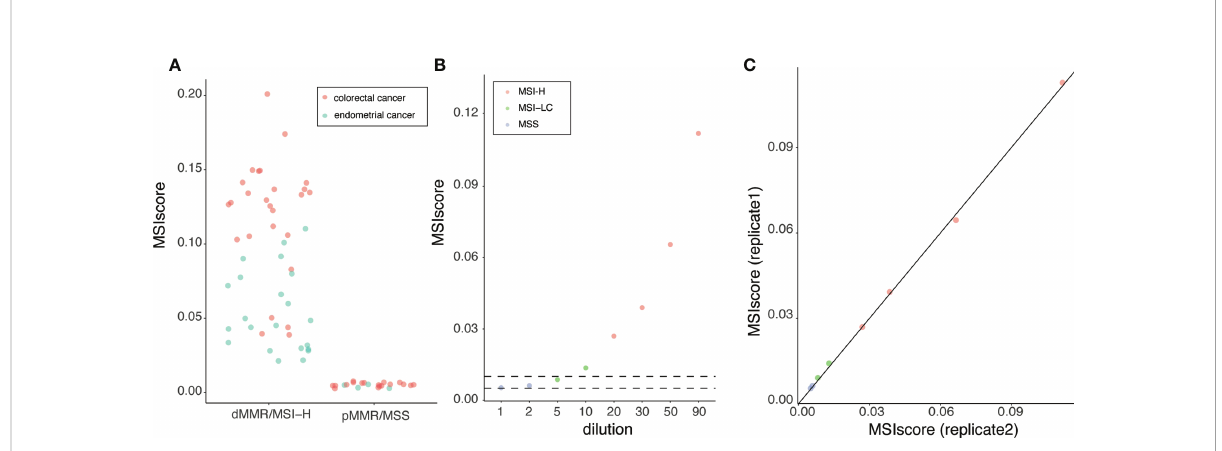
FIGURE 3 MSI detection in colorectal and endometrial FFPE clinical samples (A) MSIscore obtained for colorectal or endometrial cancer samples. Samples were grouped based on their respective MSI-PCR and IHC result. Each point corresponds to one sample colored by tissue of origin (refer to legend in fi gure) (B) MSIscore for a dilution series containing between 1 and 90% (x-axis) of DNA extracted from one MSI-H tumor DNA diluted in MSS tumor DNA in duplicates. Each point corresponds to one sample. Samples are colored according to results of MSI-PCR test (refer to legend in fi gure). (C) MSIscore obtained for replicate 1 and 2 for dilution series of MSI-H DNA in MSS DNA.